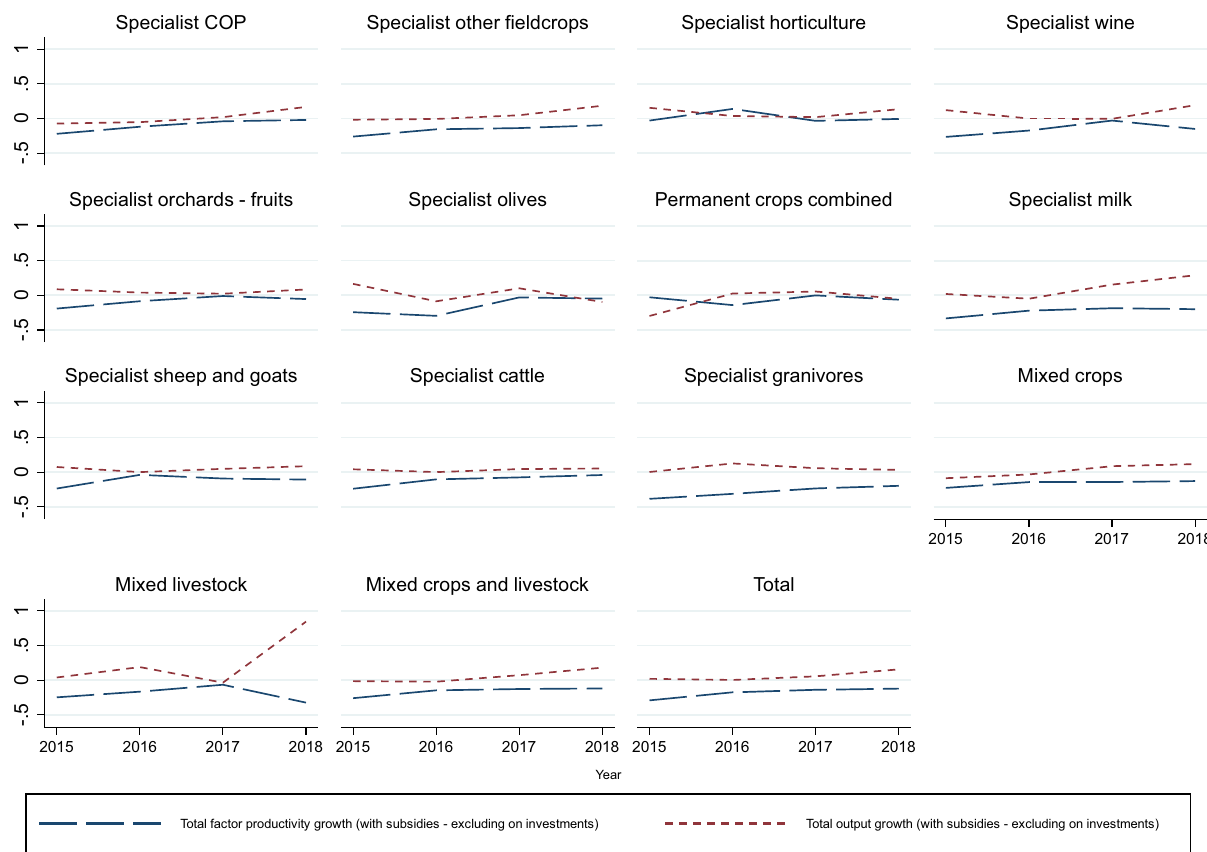
Figure 11: Evolution of the total factor productivity ( Malmquist index ) and total output growth rates ( including subsidies ) , over the period 2014 – 2018, for several EU farm